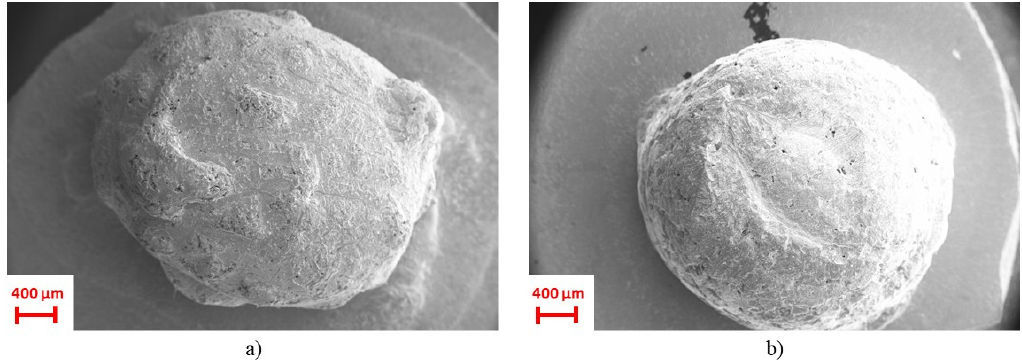
Figure 8. Top view of the drops for samples ( a ) Fe100_SPS and ( b ) Fe80_SPS in contact with pure Sn.